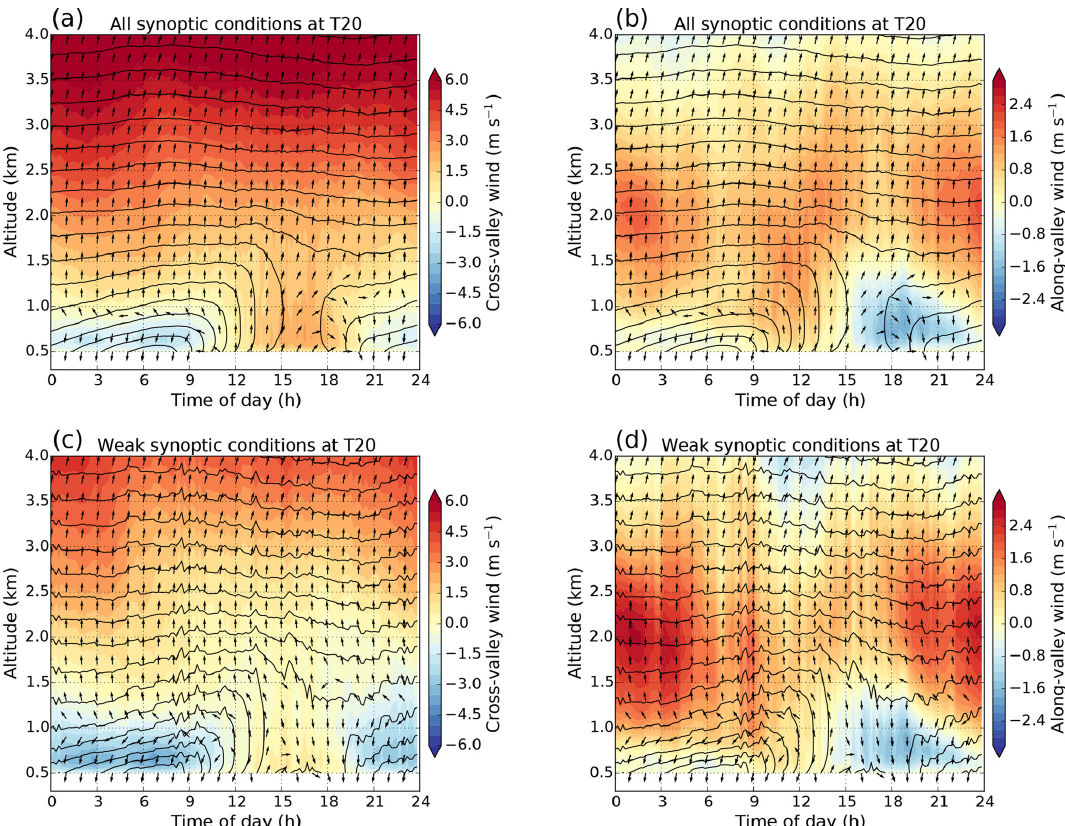
Figure 13. WRF D3 mean diurnal vertical profiles of (a, c) cross- and (b, d) along-valley winds at tower T20. The averaging period was 1 May to 15 June 2017. In panels (a) and (b) , all data of this period were used for averaging, while in panels (c) and (d) , only cases with weak synoptic conditions (defined by horizontal wind speeds < 10ms − 1 at 3000m altitude) were utilized. Negative cross- (along-)valley winds indicate flow from the NE (NW) directions, respectively. Black arrows show the mean horizontal wind direction (north is indicated at the top). Black contour lines mark isentropes with a contour interval of